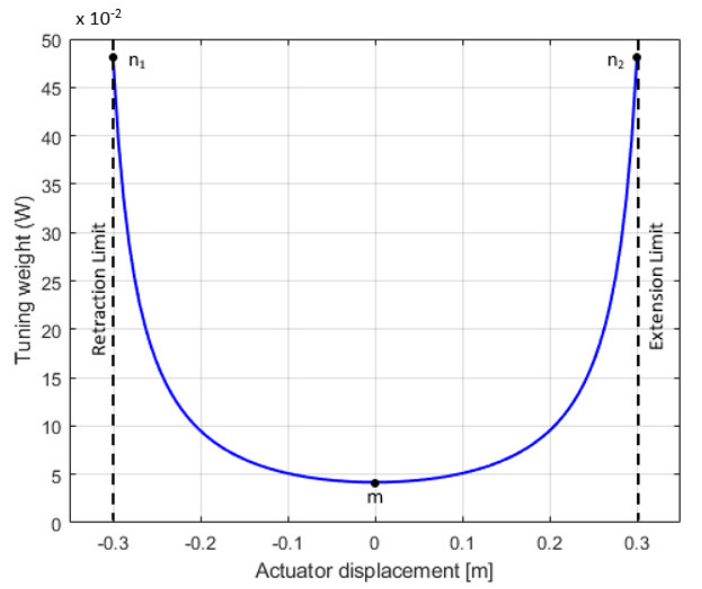
Figure 5. The effect of actuator displacement on the tuning weight.